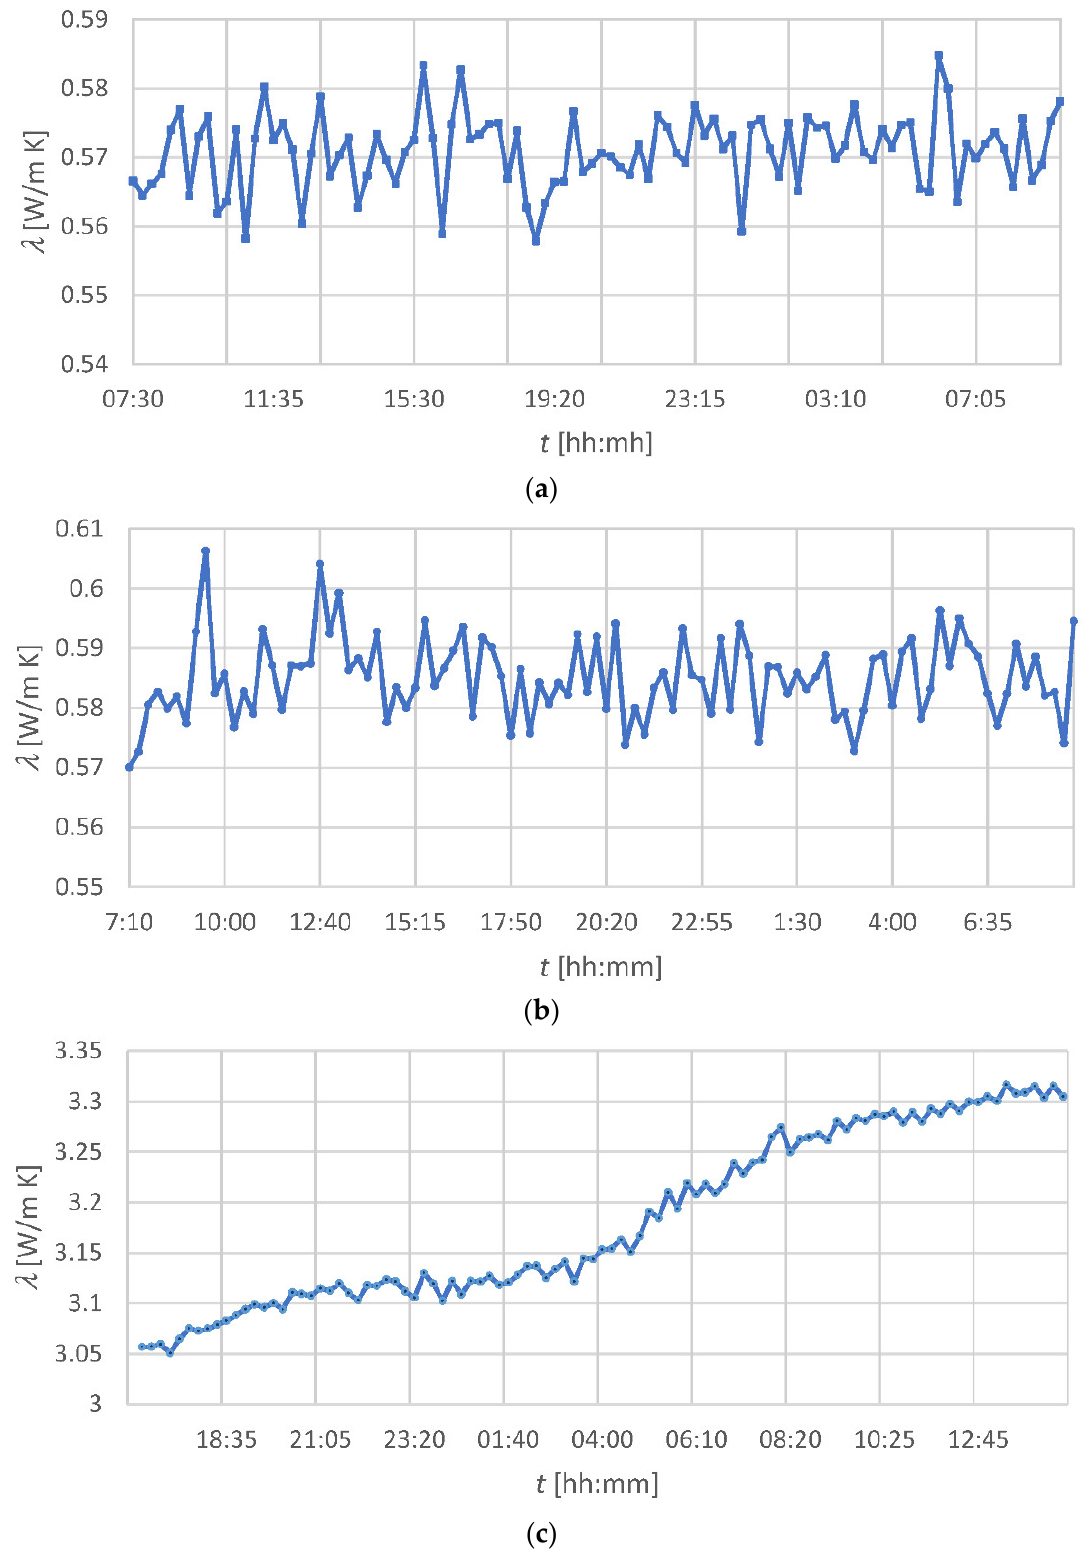
Figure 4. Thermal conductivity of a mixture of bentonite and water: ( a ) 3% bentonite on a weight ratio to water; ( b ) 9% bentonite by weight to water and ( c ) a mixture of CableCem and water, 150% CableCem by weight to water.